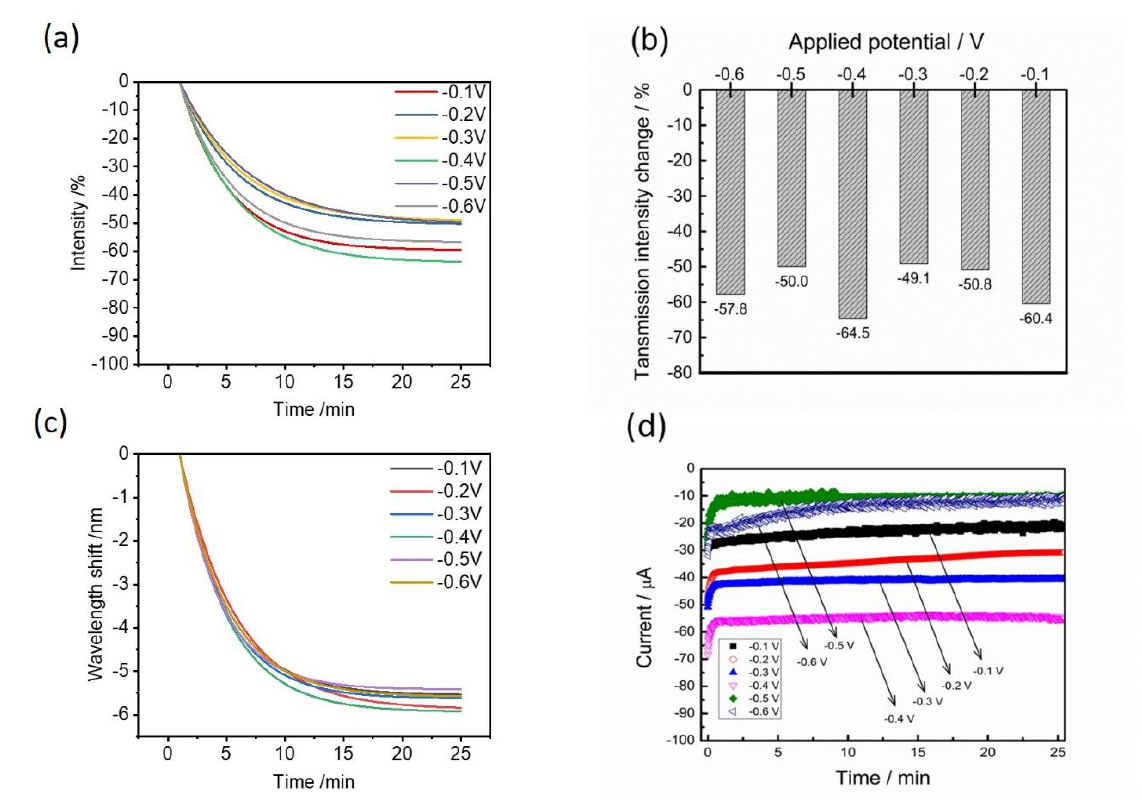
Figure 5. ( a ) Time-dependent SPR intensity changes and ( b ) time-dependent wavelength shifts under various applied potentials. ( c ) The comparison of the steady-state SPR intensity and wavelength changes under various applied potentials. ( d ) The electrochemical current responses at various applied potentials between −0.1 and −0.6 V. Electrolyte: 100 μM Hg 2+ in 10 mM KCl solution.